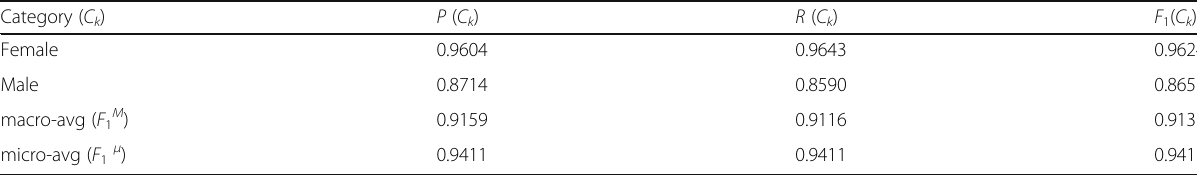
Table 9 Results with norm-TF with cross validation = 3